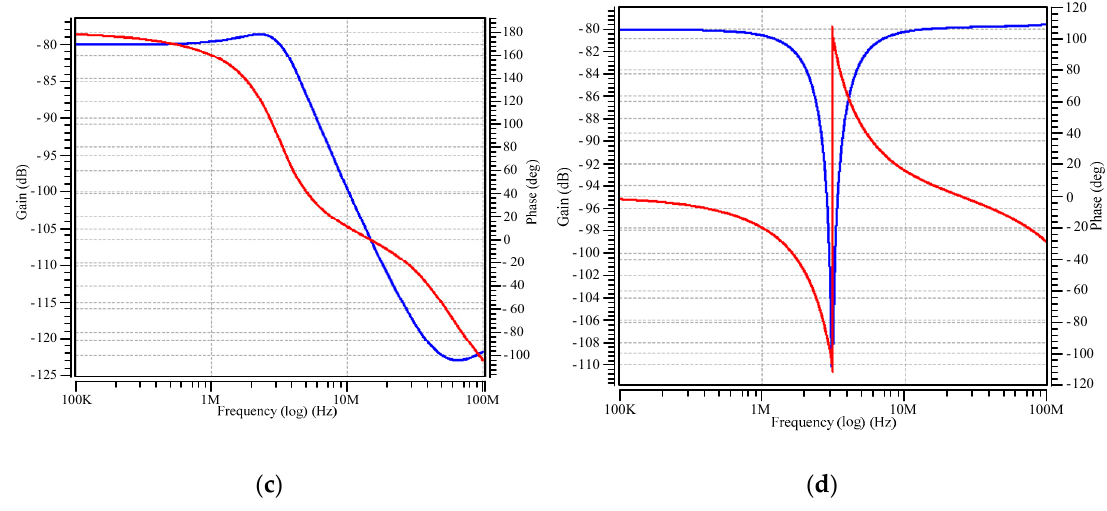
Figure 18. The TAM post-layout gain (blue line) and phase (red line) simulation responses ( a ) highpass filter (I o1 /V in ); ( b ) bandpass filter (I o2 /V in ); ( c ) lowpass filter (I o3 /V in ); and ( d ) bandstop filter (I o4 /V in ).